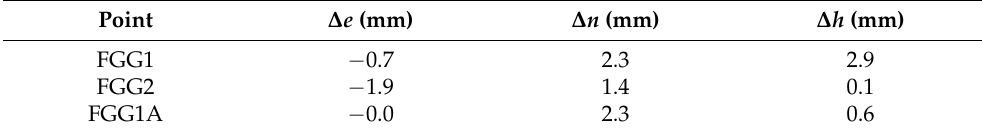
Table 13. The coordinate